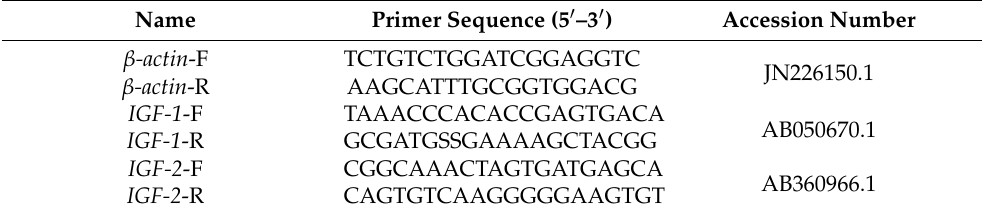
Table 4. Forward (F) and reverse (R) primers were used for growth-related mRNA quantitative real-time